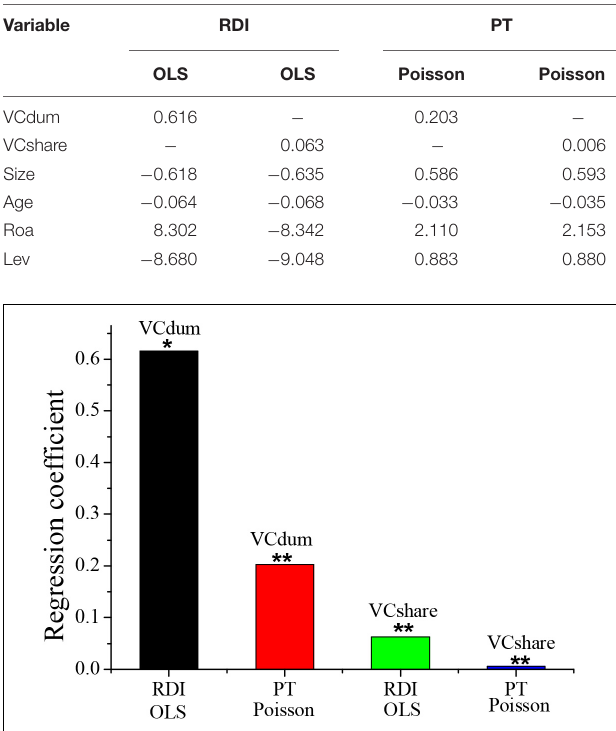
FIGURE 3 | The impact of venture capital on technological innovation of enterprises. * and ** indicate significant positive correlations at 10 and 1% levels, respectively.